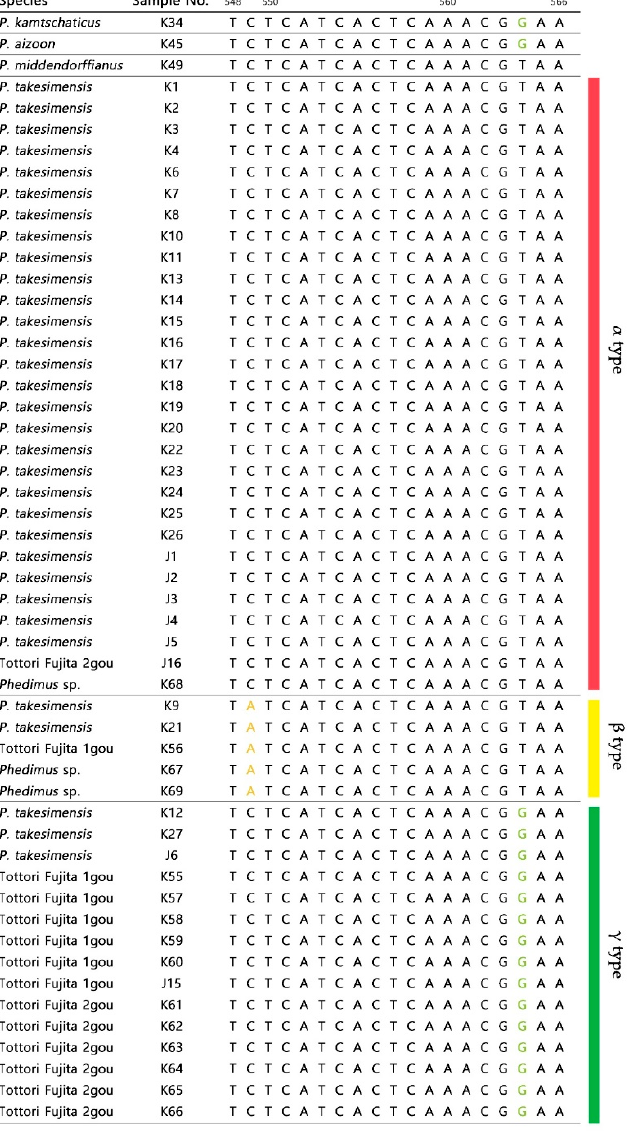
Figure 2. Three types based on nucleotide substitution in internal transcribed spacer (ITS) sequences of P. takesimensis , cultivar “Tottori Fujita 1gou” and “Tottori Fujita